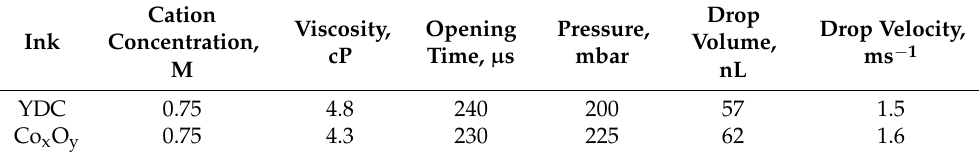
Table 1. Solution infiltration inks’ viscosities and jetting